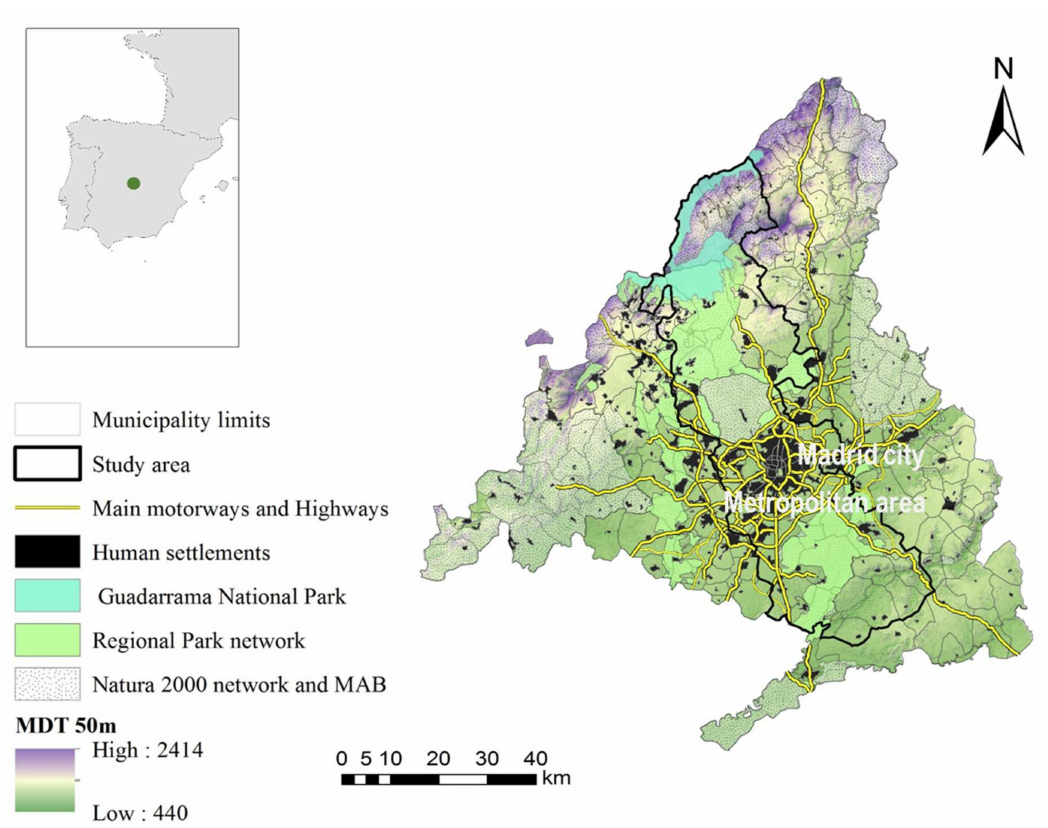
Figure 1. Location of the Madrid Region in Central Spain. Limits of the study area (rural-urban gradient), boundaries of the municipalities, human settlements, area occupied by the PA network, and main motorways and highways are shown. The steep altitudinal gradient of the study area was mapped with a